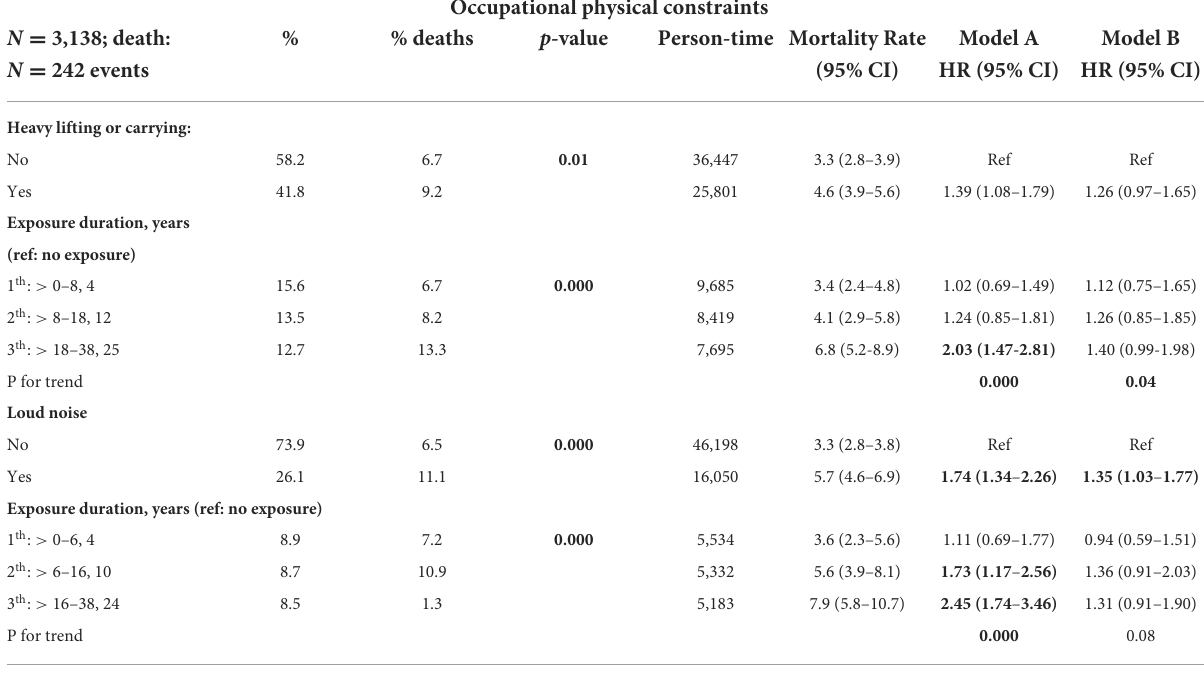
Occupational physical